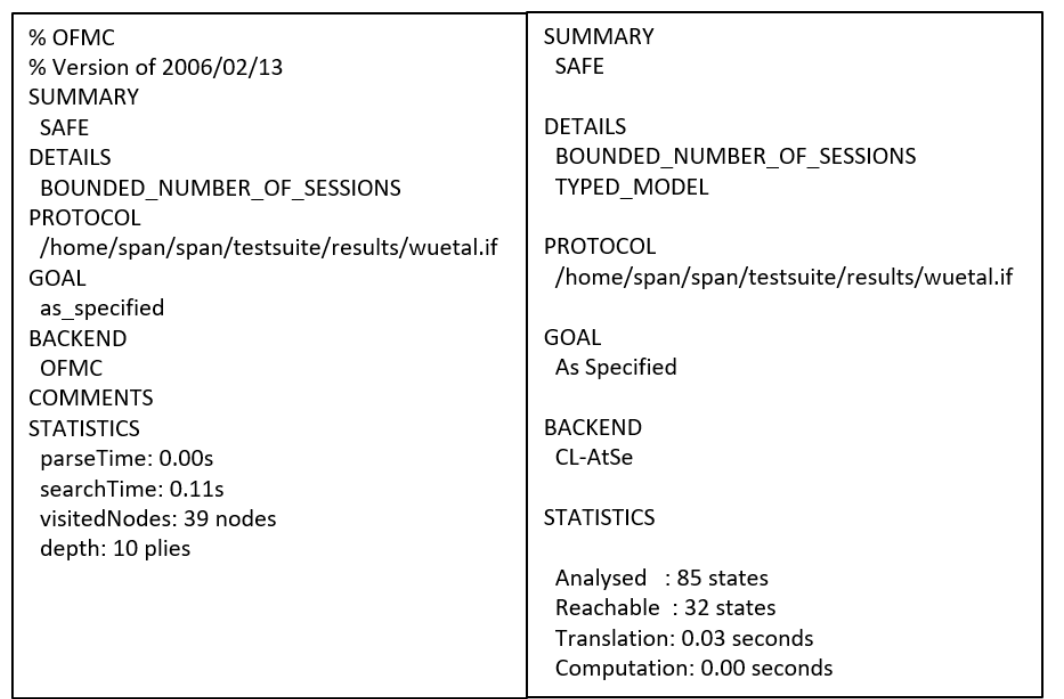
Figure 7. AVISPA result of Wu et al.’s protocol.